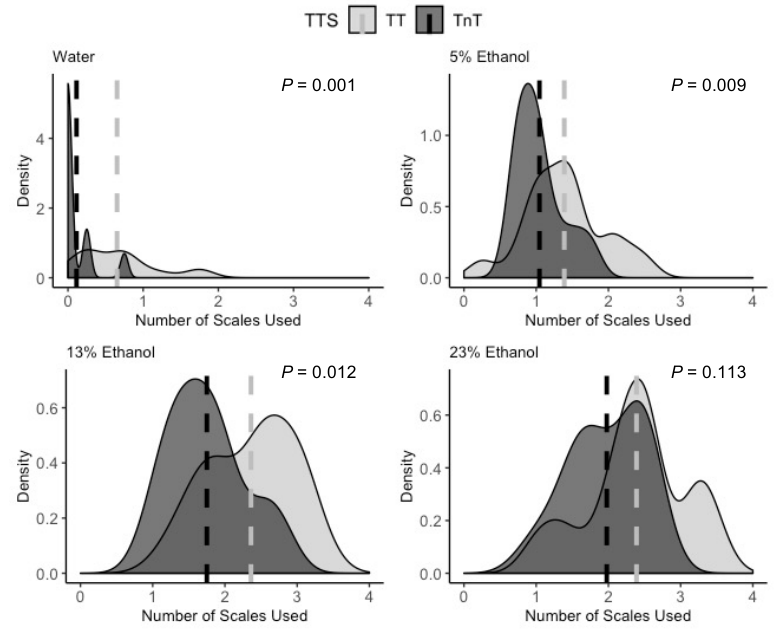
Figure 8. Kernel density estimates of the mean number of scales used by thermal tasters (TT, n = 18) and thermal non-tasters (TnT, n = 11) when rating unary aqueous solutions of ethanol (0%, 5%, 13% and 23% v/v ). Dashed lines indicate the median values and p-values indicate whether the medians differ significantly (NS = not significant).